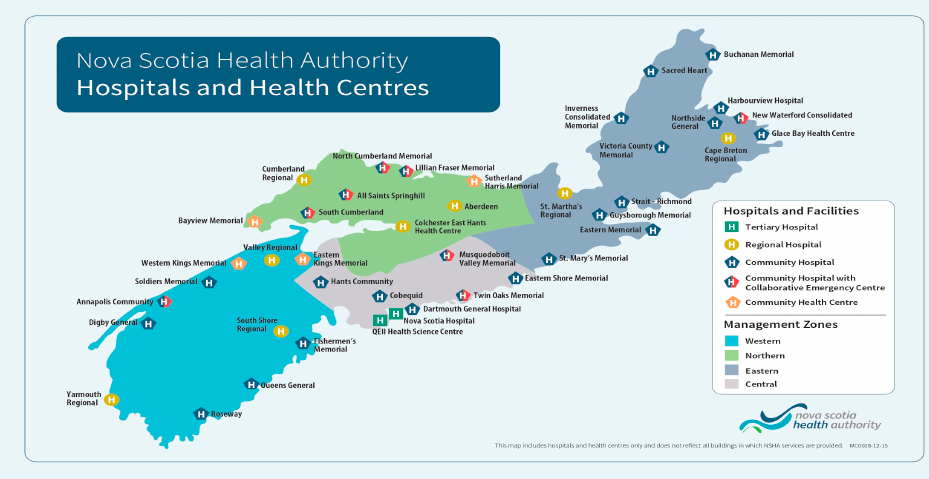
Figure 11. Percentage of endoscopic surgical services completed or wait times within benchmark [84].